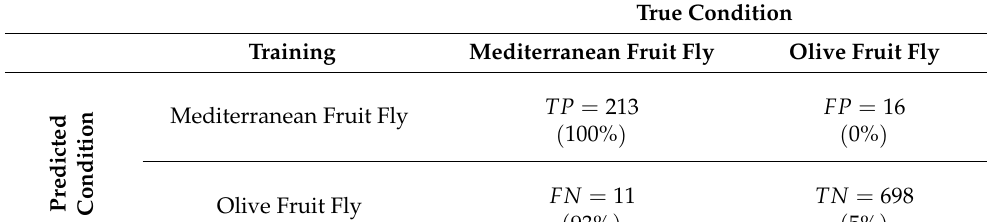
Table 4. YOLO training confusion matrix results.